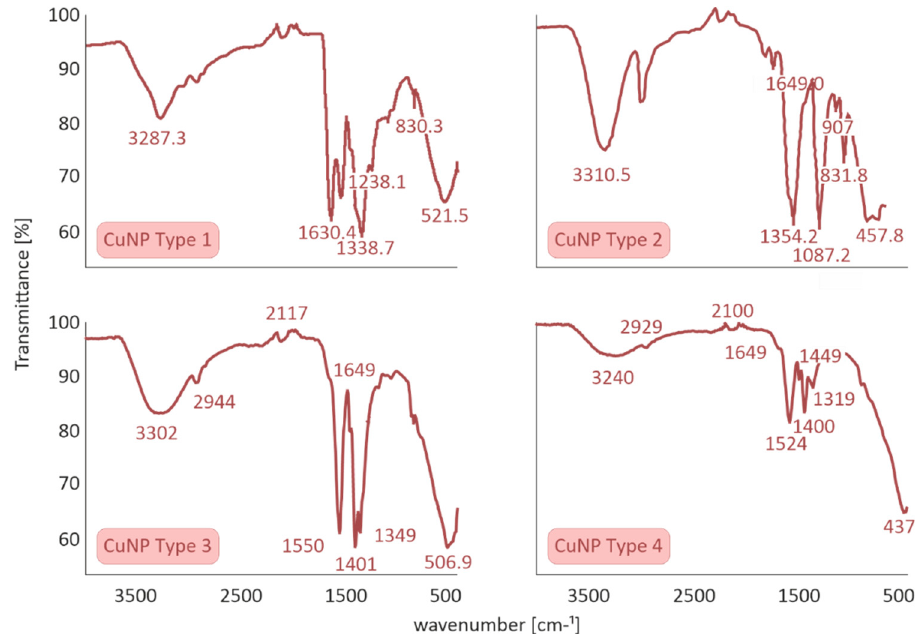
Figure 3. Attenuated Total Reflection (ATR) spectra of all four CuNPs species performed on a Cary 630 FTIR Spectrometer by Agilent Technologies.